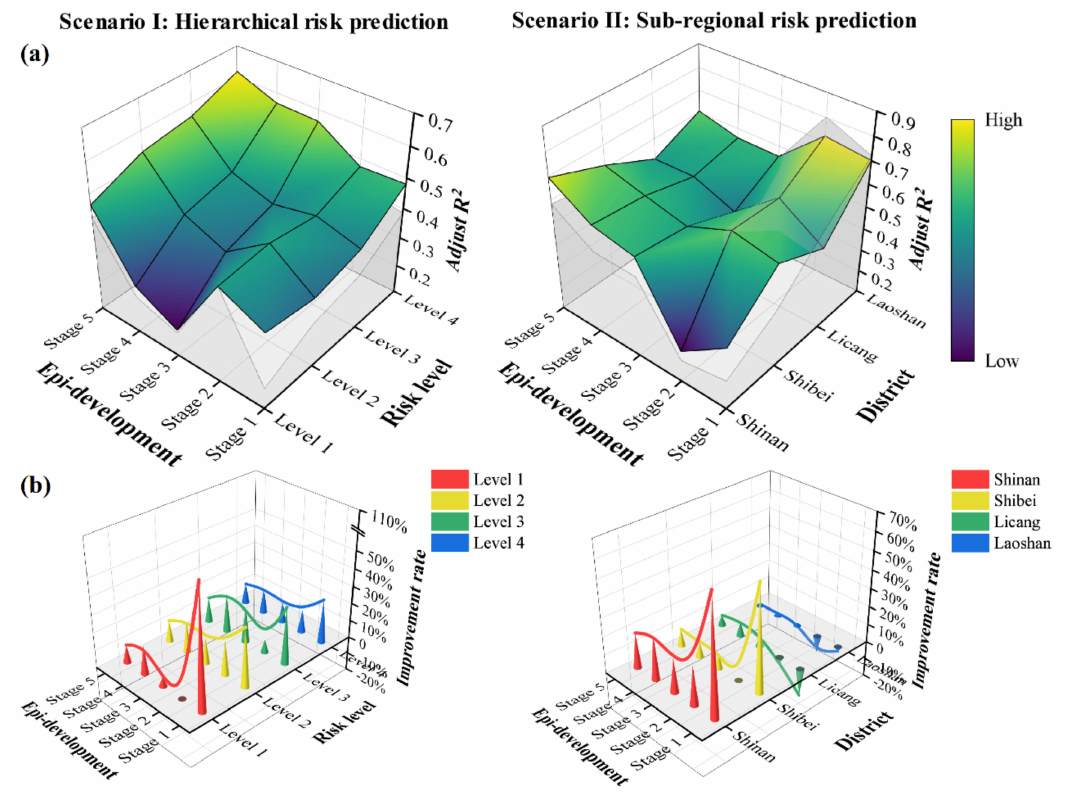
Figure 5. Comparison of the effectiveness of the model prediction between FDs and FAs in two types of application scenarios: ( a ) temporal trend of the effectiveness of the differentiation of the two models (the colored surface is the optimized model, while the gray surface and side filling represent the traditional model); ( b ) improvement